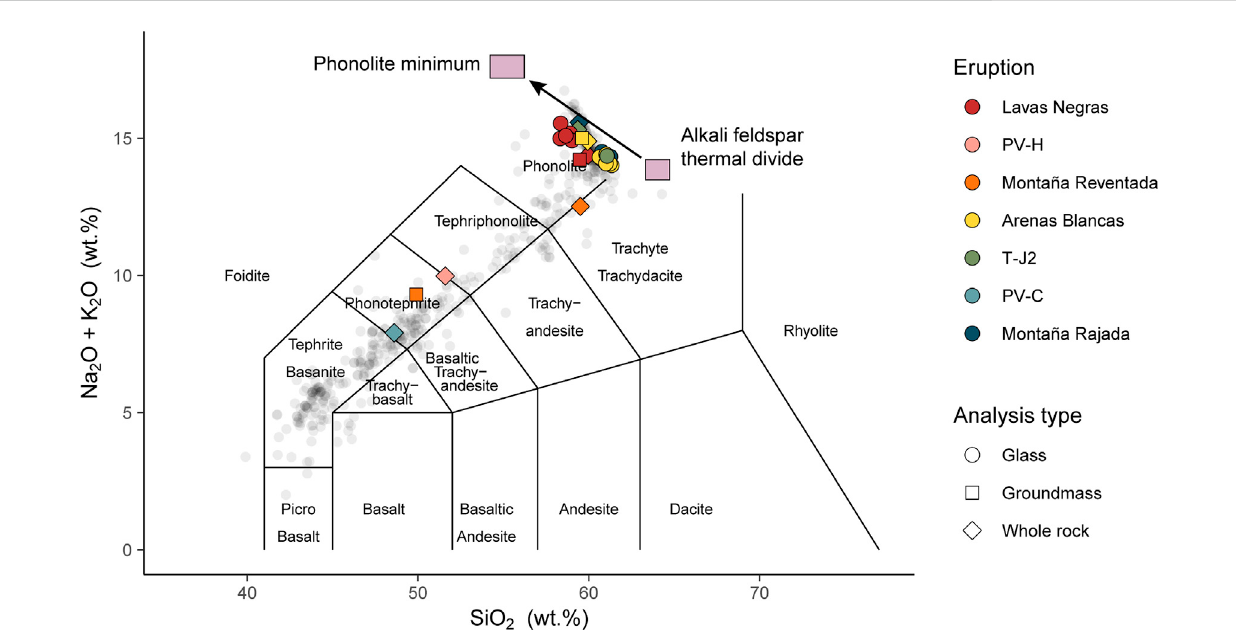
FIGURE 3 Total alkalis vs silica diagram (TAS) plot (Le Bas et al., 1986) showing glass, groundmass and whole rock analyses of the Tenerife samples used in this study.Major elements arenormalizedto 100%(anhydrous). Hand-pickedgroundmassfrom Brown etal. (2022) andRamosetal. (inprep)are also shown. ThegreycloudofpointsarefromrecenteruptionsonTenerifeavailableintheliterature(Ibarrola,1970;Ridley,1970;Brändle,1973;CabreraLagunillaand Hernández Pacheco, 1987; Araña et al., 1989; Araña et al., 1994; Balcells and Hernández-Pacheco, 1989; Fernández Satín and Vicente-Mingarro, 1989;GarcíaMoral,1989;Ovchinnikovaetal.,1995;Ablay,1997;Neumannetal.,1999;RodríguezBadiolaetal.,2006;Wiesmaieretal.,2011;Garcíaetal., 2012; Albert et al., 2015a; di Roberto et al.,